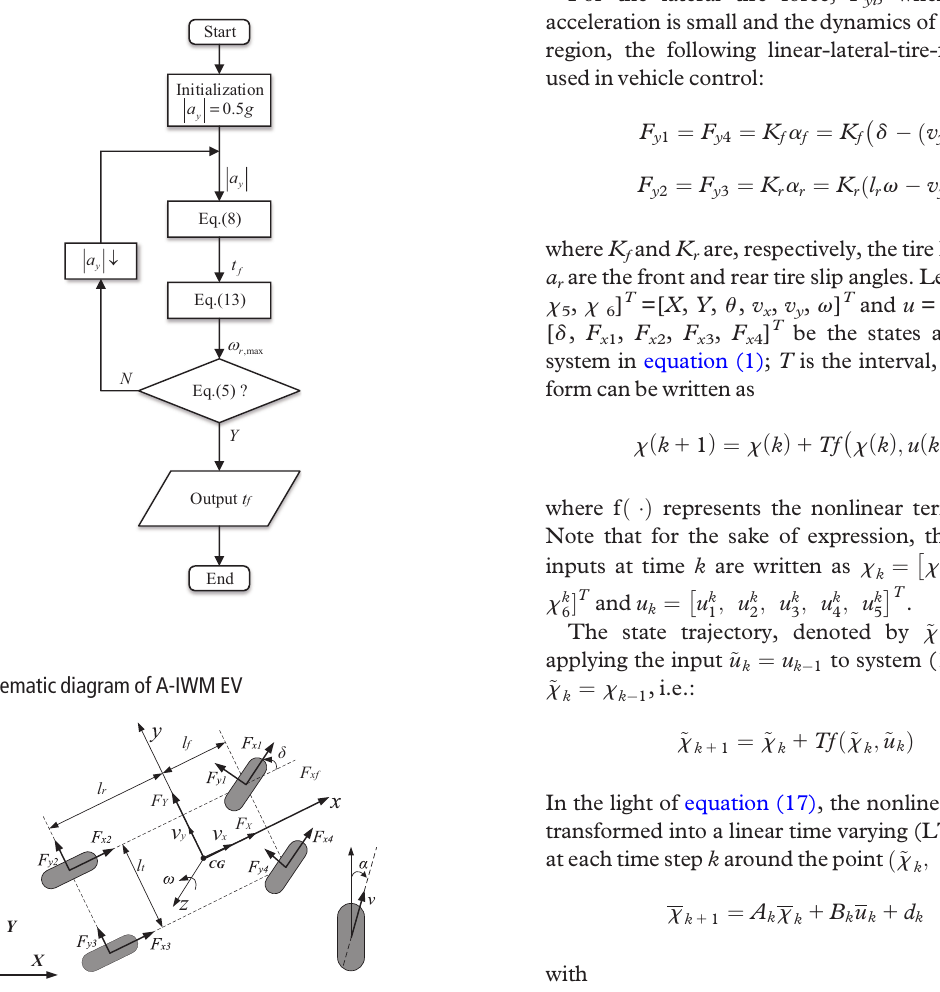
Figure 3 The diagram of the search algorithm to fi nd the optimal t (cid:4) f